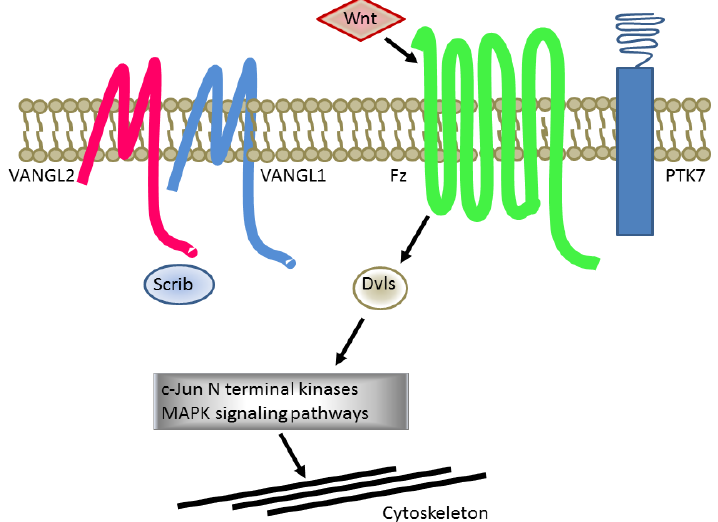
Figure 2. PCP proteins have causative effects in NTDs. Schematic illustration of PCP proteins VANGL2 and paralog VANGL1 alongside other PCP proteins including Frizzled (Fz), PTK7, Scrib and Disheveled (Dvls). Downstream signaling of PCP implicates